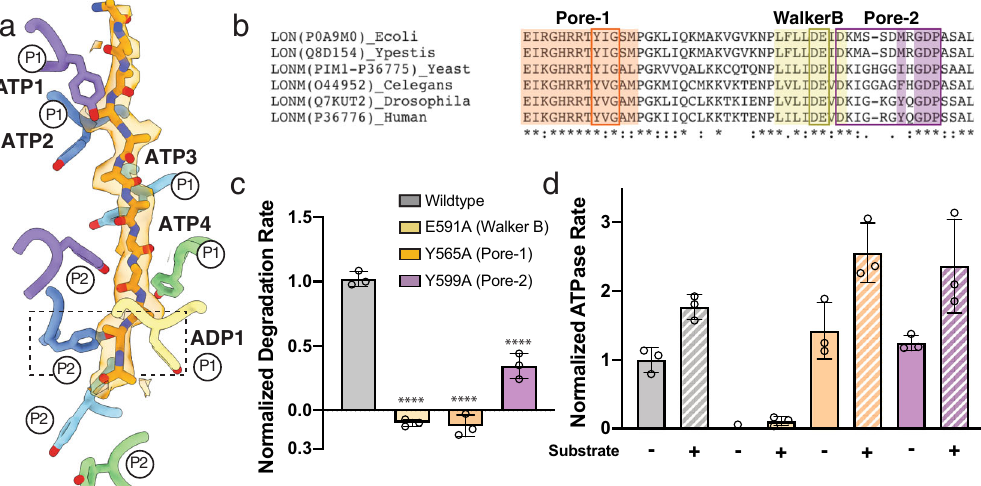
Fig. 2 LONP1 employs two pore loop aromatic residues to facilitate substrate translocation. a A twelve-residue polyalanine chain is modeled into the substrate density found in the substrate-bound human LONP1 structure, shown in a transparent orange surface representation. Y565 from pore-loop 1 (labeled P1) is shown using stick representations. Y565 residues from ATP1-4 and ADP1 subunits show intercalating, zipper-like interactions with substrate. Y599 from pore loop 2 (labeled P2) also shows intercalating interactions with substrate in the ATP1 (purple) and ATP2 (dark blue) subunits. b Sequence alignment between LONP1 homologs highlighting evolutionary conservation within pore loop 1 and Walker B motifs, as well as the evolutionary integration of a hydrophobic residue into pore loop 2 in metazoans. c Introducing pore loop mutations Y565A or Y599A shows a decrease in the degradation rate of a model substrate, FITC-casein. The hydrolysis-blocking Walker B mutation E591A is included as a control. Data are presented as bar graphs showing mean values with error bars showing standard deviation from three independent replicates. **** p < 0.0001 relative to wild type calculated by one-sided ANOVA. d Basal-level ( fi lled bars) and casein-stimulated (hatched bar) ATPase rates are shown for the same mutations as in ( c ). Data are presented as bar graphs showing mean values with error bars showing standard deviation from three independent replicates. Error bars show standard deviation from three independent replicates.